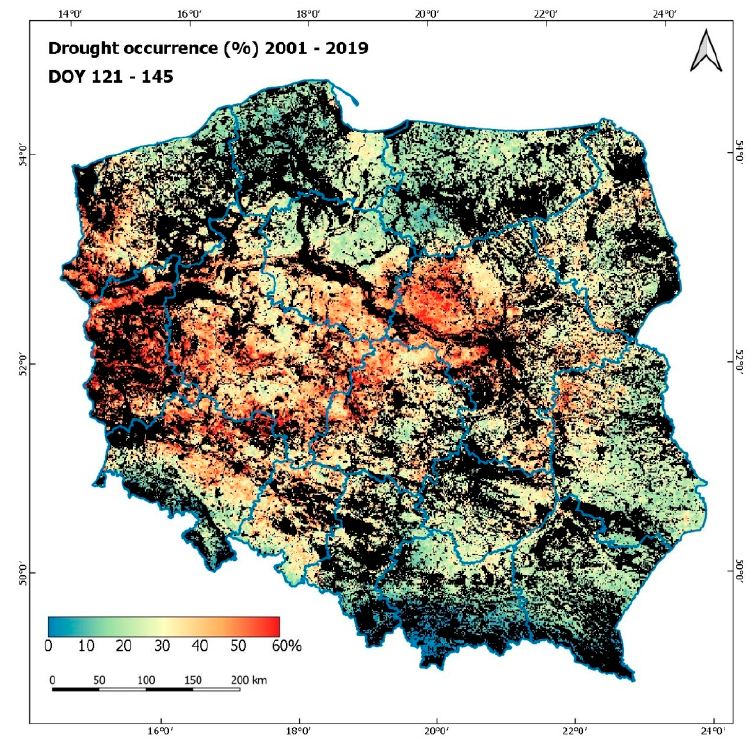
Figure 26. Percentage of drought occurrence in the 2001–2019 period (May 01–May 24).